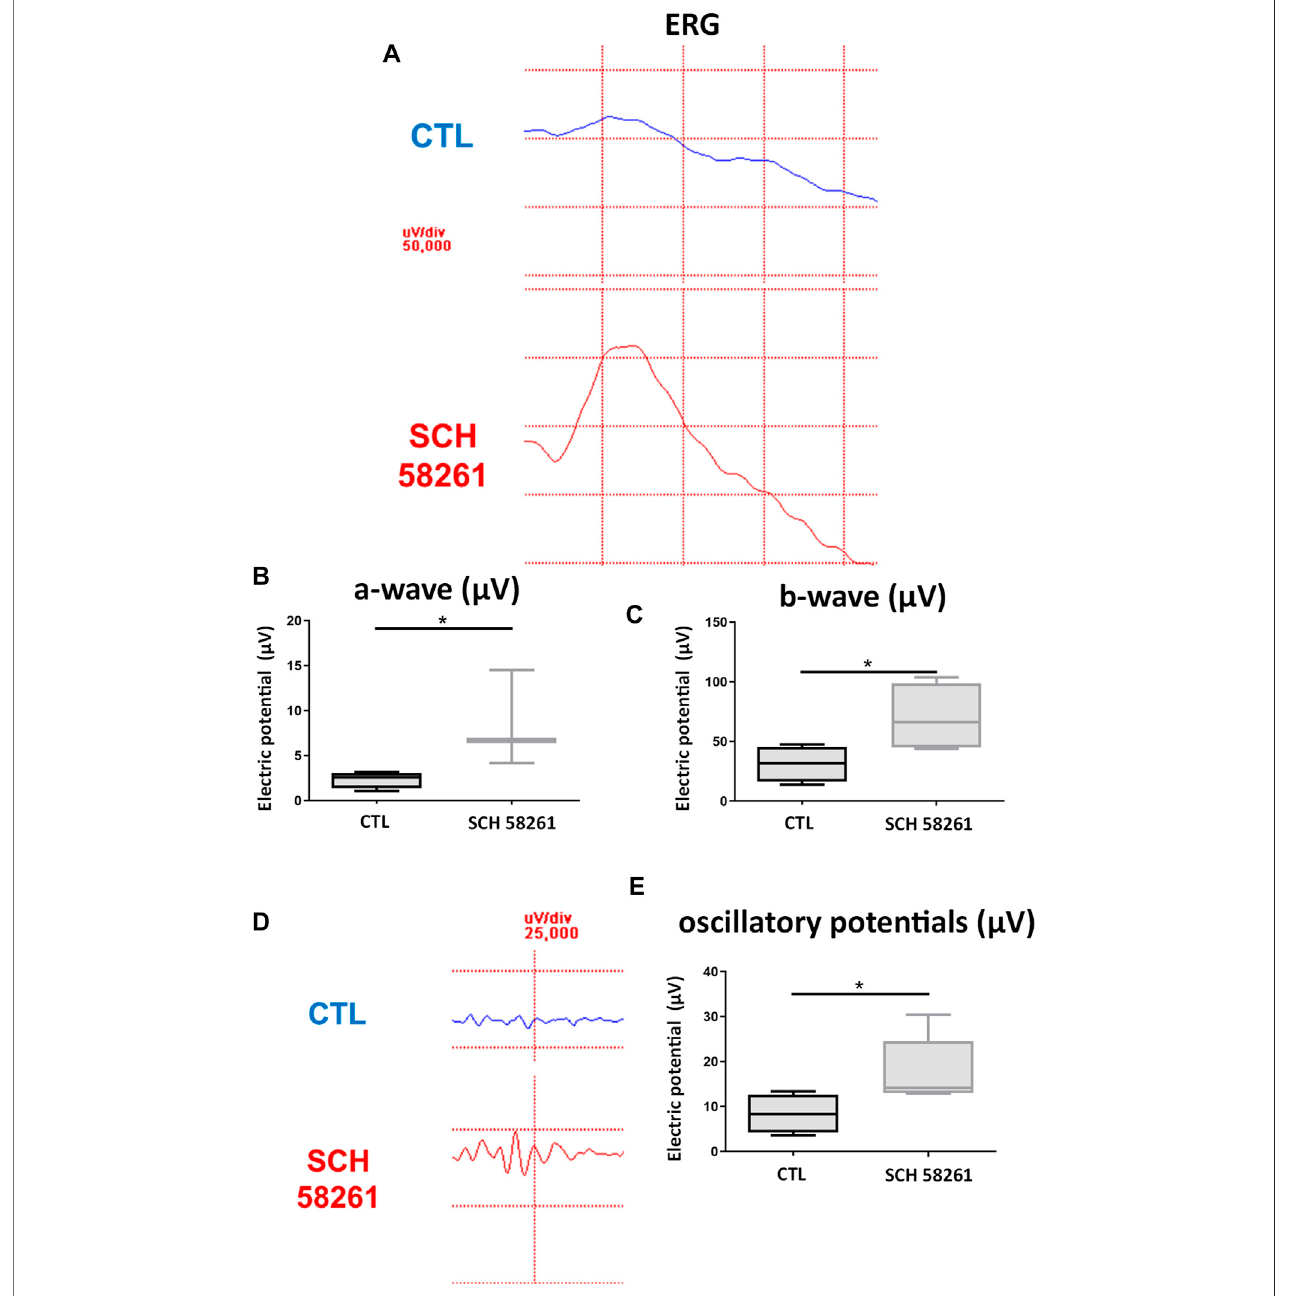
FIGURE 7 | Effect of treatment with SCH58261 on ERG recordings post CI. (A) ERG recording 1 week after exposure to 24 h of CI of a CTL eye (above) and an SCH58261-treated eye (below). (B) Quanti fi cation of a-wave. (C) Quanti fi cation of b-wave. (D) Response of oscillatory potentials 1 week after 24 h of CI of a CTL eye (above)andanSCH58261-treatedeye(below). (E) Quanti fi cationofOP.Boxesrepresent25and75percentiles,whiskersrepresentminimumandmaximumvalues,and transverse lines represent medians. Student ’ s t -test,* p < 0.05.